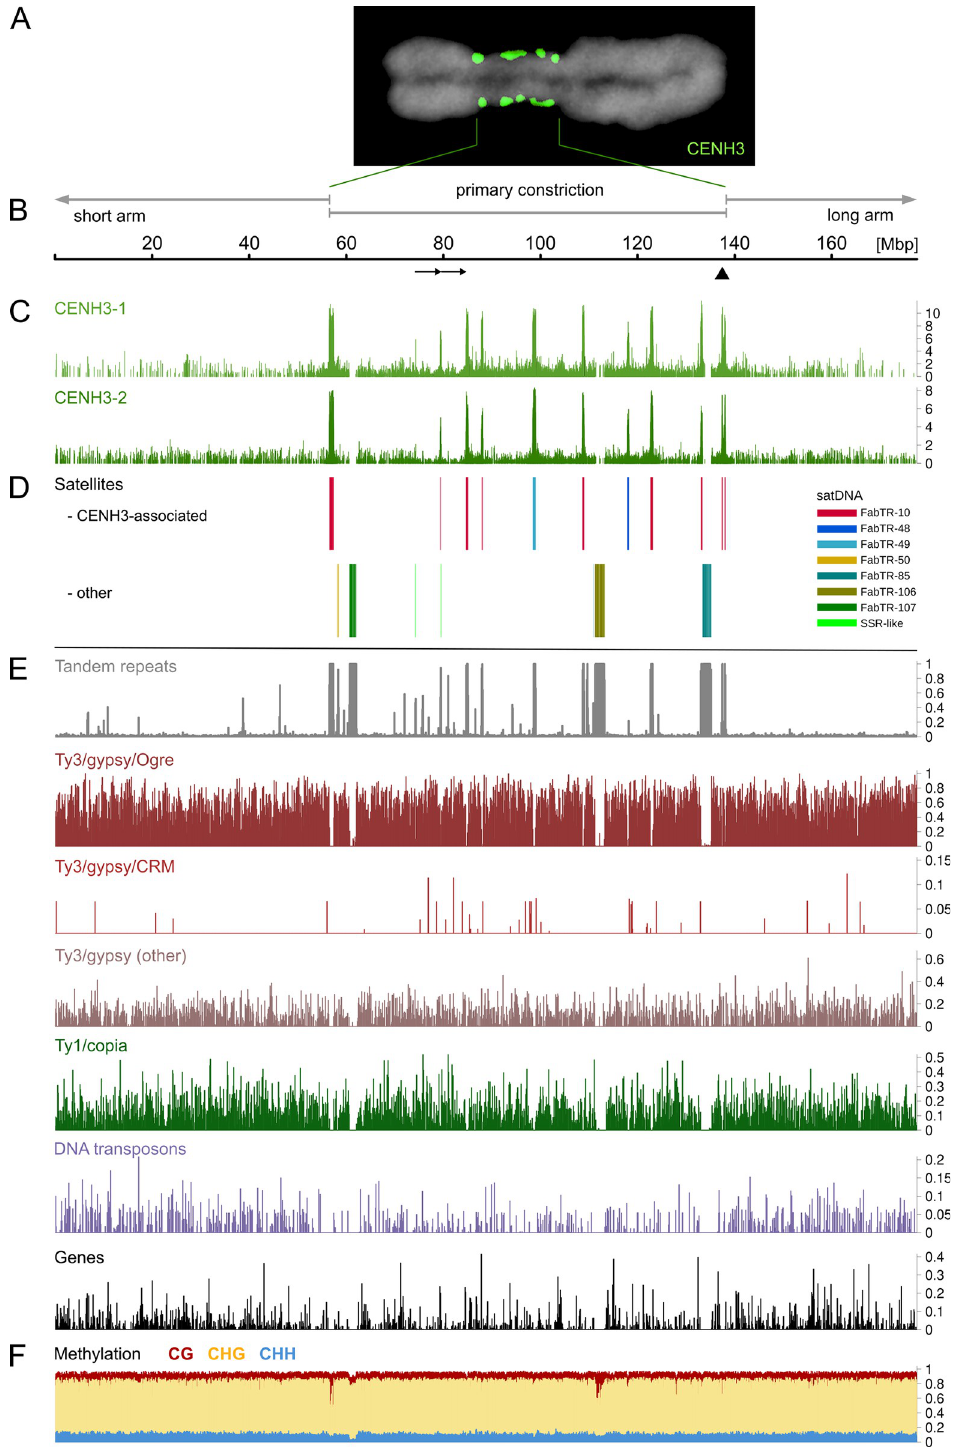
Fig 1. Features of pea centromere 6 (CEN6). (A) Immunolabeling of CENH3 protein (green) on metaphase chromosome 6 (counterstained with DAPI, gray). (B) Position of the primary constriction in the assembly. Arrows below the scale indicate the 5.2 Mb tandem duplication, and the arrowhead shows the position of a single gap in the assembly. (C) Distribution of CENH3 chromatin revealed by ChIP-seq experiments using anti-CENH3-1 and anti- CENH3-2 antibodies. Peaks in the graphs correspond to the statistically significant enrichment ratio of ChIP reads to